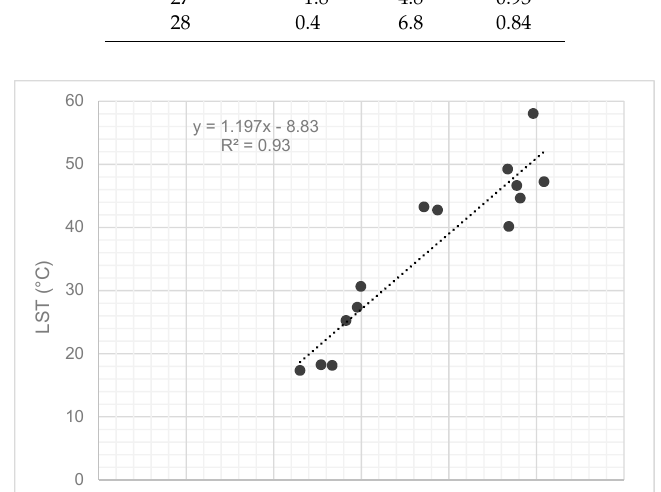
y = 1.197x - 8.83 R² = 0.93